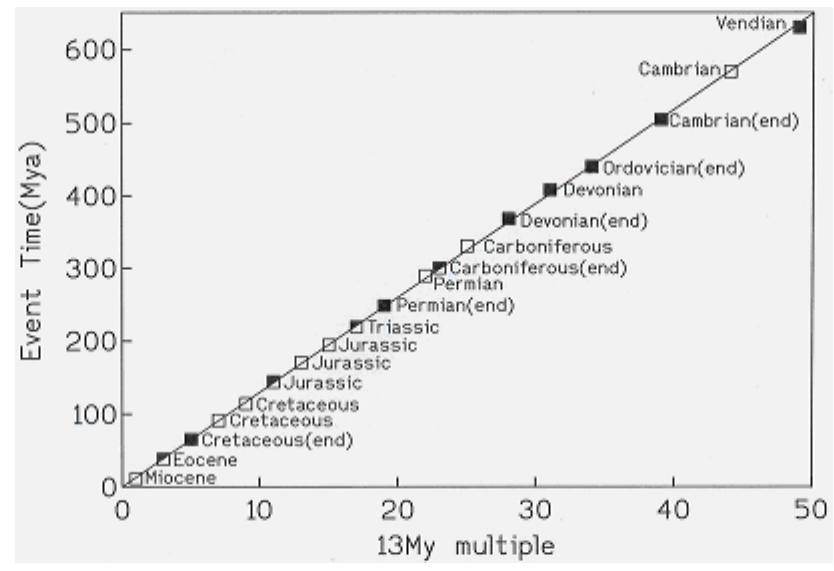
FIGURE 1. A linear plot of extinction event time (mya) vs. multiple of 13 my for mass extinctions over the Phanerozoic aeon. Major extinction events are shown in black whereas moderate ones are in black and white. The data used are from Table